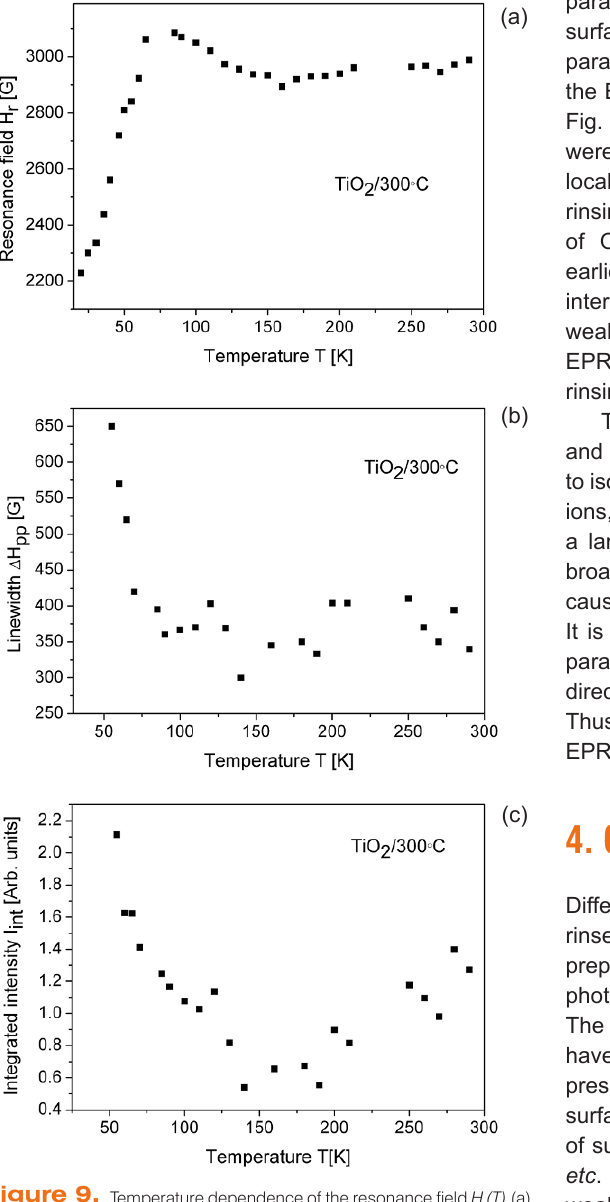
(T) (b), and integrated intensity I linewidth Δ H pp the broad line in [TiO /300ºC] 2